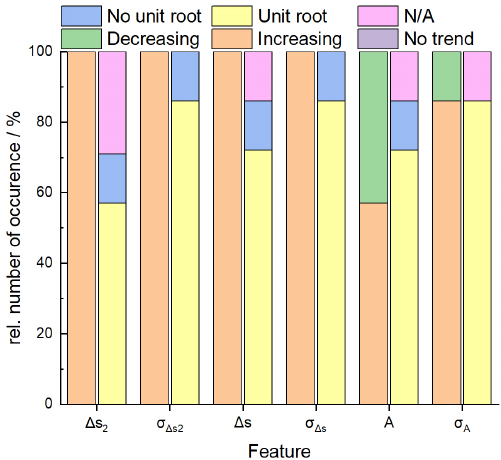
Figure 5. Relative number of occurrence for the trend behaviour and the presence of a unit root for the measurands in the long-term tests with a clear quality degradation. For each measurand, the mean over time and the standard deviation over time is tested. The left stack of bars represents the respective trend behaviour, while the right stack shows the presence of unit roots. If the ADF and KPSS tests show conflicting results, the time series is listed as